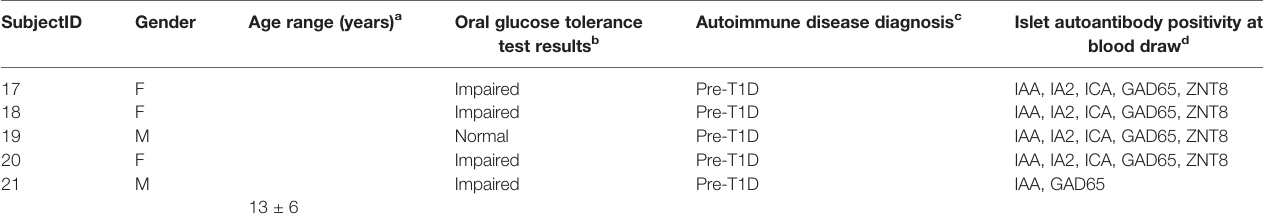
TABLE 2 | Type 1 Diabetes TrialNet participant